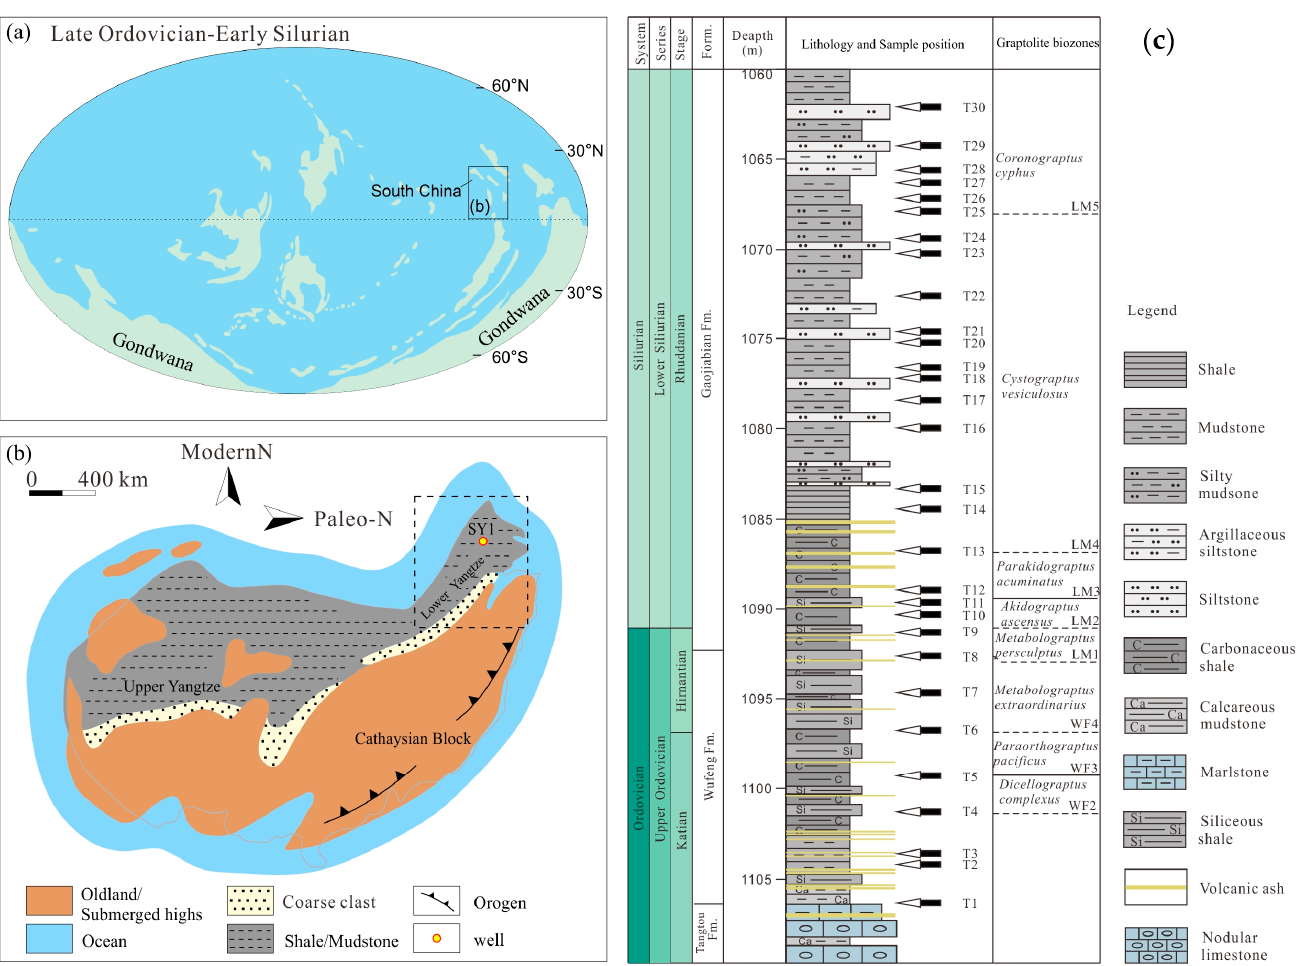
Figure 1. ( a ) Global paleogeography of the O/S transition (modified from [25]); ( b ) Paleogeography of the Yangtze region in Katian stage (modified from [18]). The dotted box shows the location of Lower Yangtze region; ( c ) Lithology and graptolite biozones of the O/S transition in the Well SY1 core from the Lower Yangtze region (modified from [26,27]). See yellow circle in Figure 1b for the location of Well SY1.